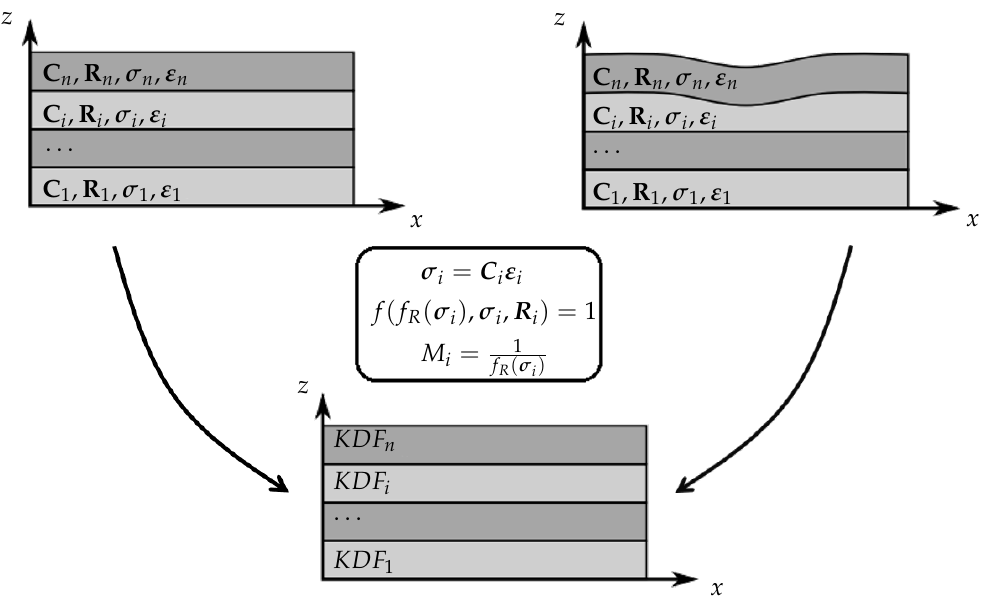
Figure 2. Illustration of homogenization approach for KDF parameter estimation based on pristine (left) and defective model configuration (right), reprinted with permission from Ref. [29], 2020, F.